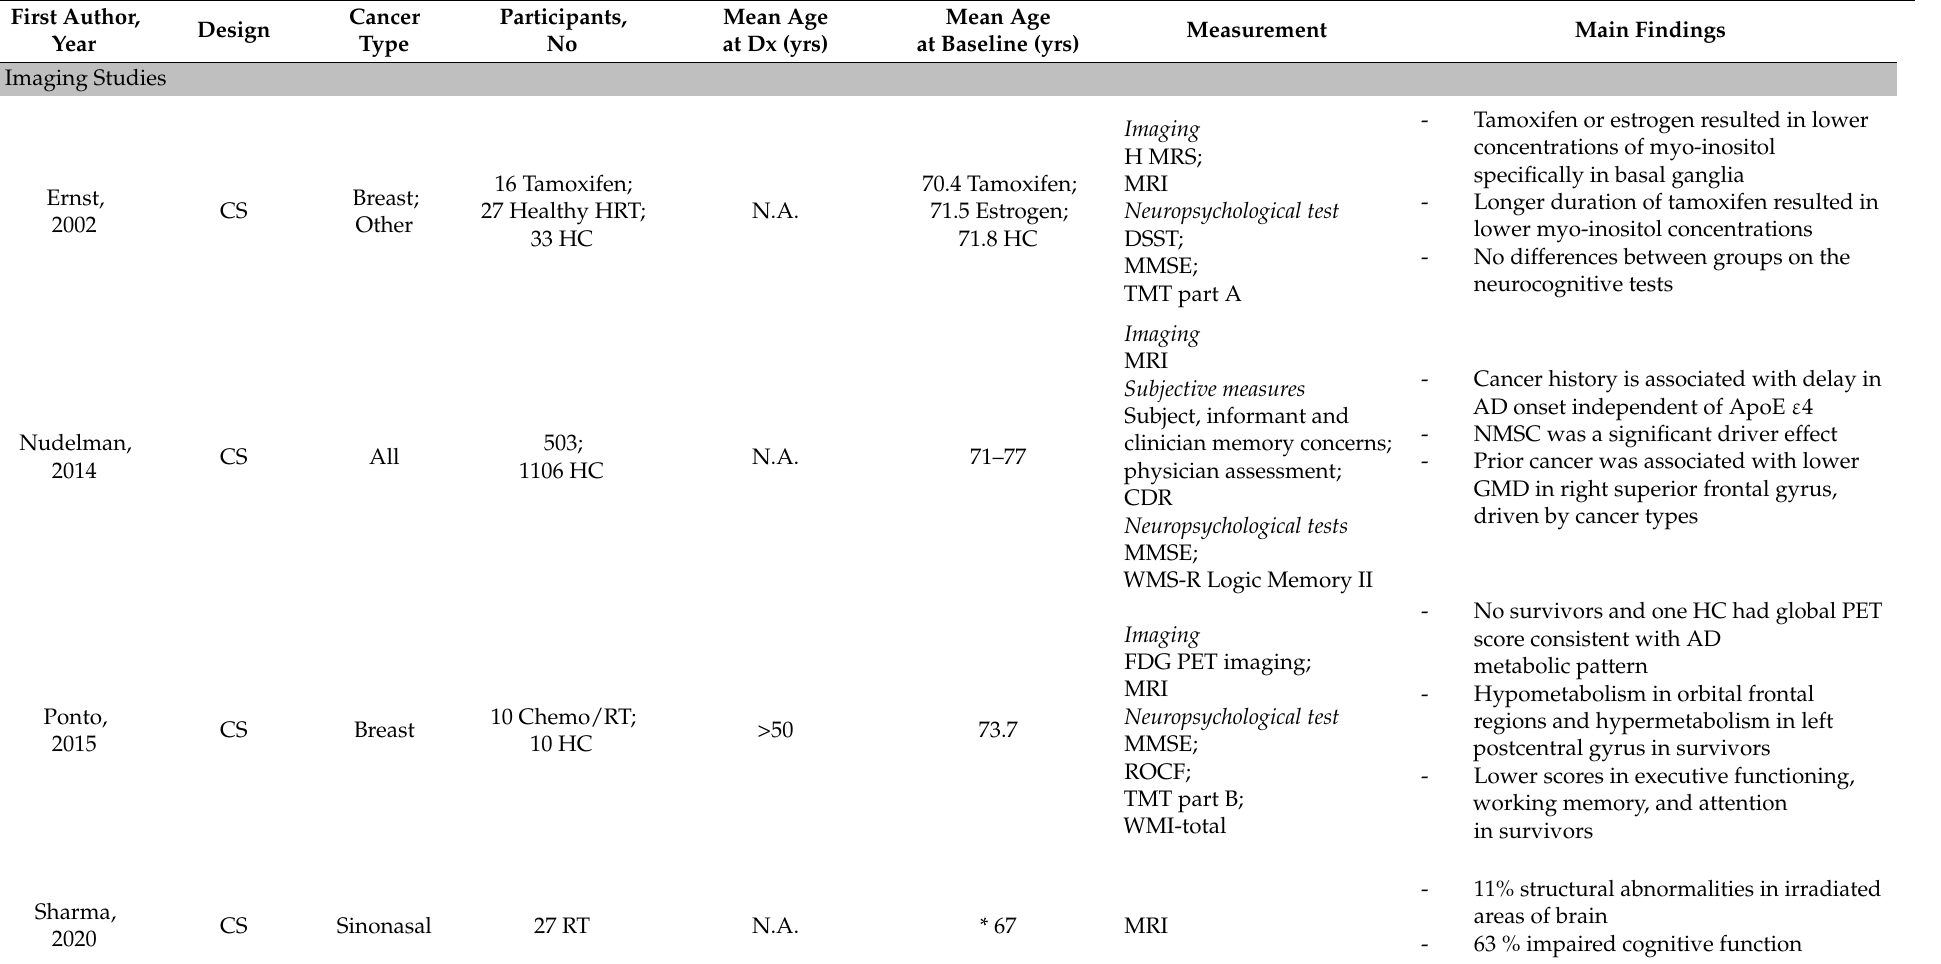
Table A1. Overview of imaging studies in older cancer survivors according to the systematic literature